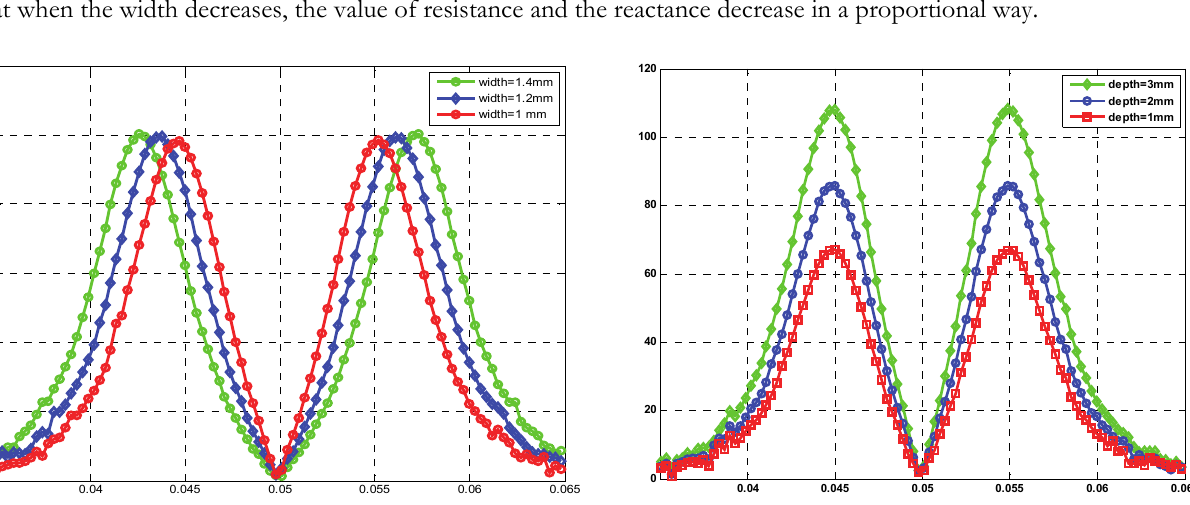
Figure 11: Impedance Z vs. crack width. Figure 12: Impedance Z vs. crack depth .